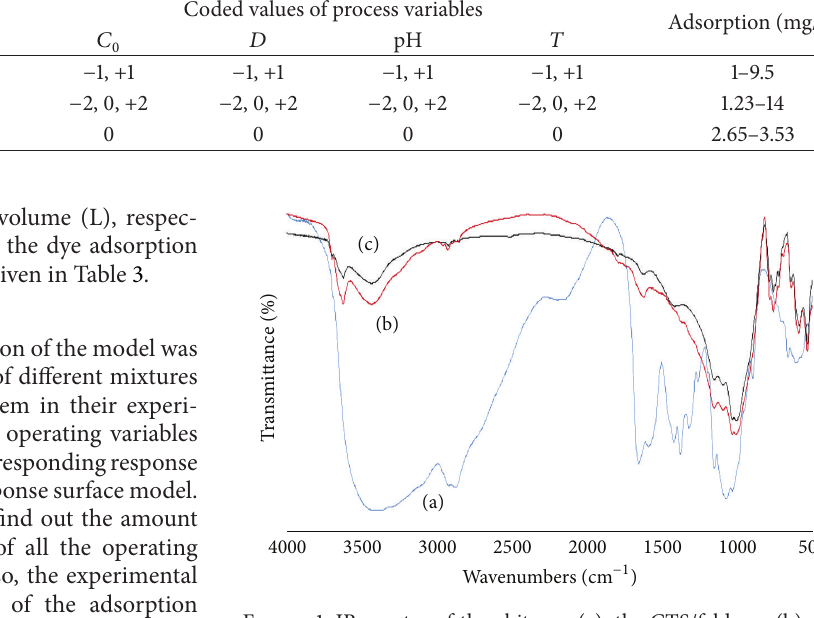
Figure 1: IR spectra of the chitosan (a), the CTS/feldspar (b), the feldspar (c).